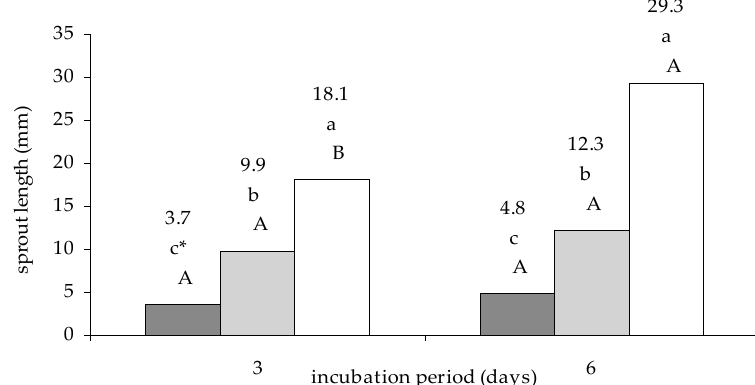
Figure 2. E ff ect of the culture filtrates from 18 strains of E. nigrum on sprout length of garden cress ( L. sativum L.) sprouts after 3 and 6 days of incubation. Means followed by the same letter (*) are not statistically di ff erent at the α ≤ 0.01 level, according to the Tukey HSD test. Small letters indicate the di ff erences in the length of sprout due to filtrate type within a given incubation period. Capital letters